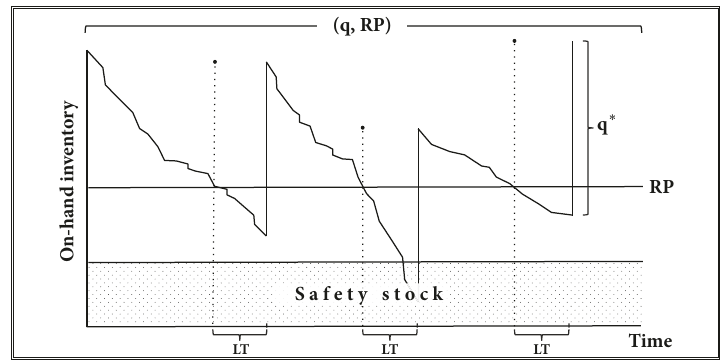
Figure 2: Continuous review inventory control policy